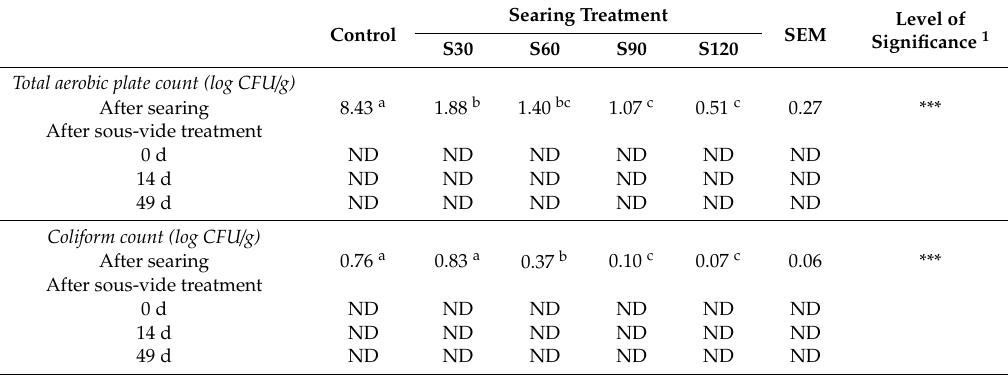
Table 5. E ff ects of searing process on total aerobic bacteria and coliforms of pork patties during storage.